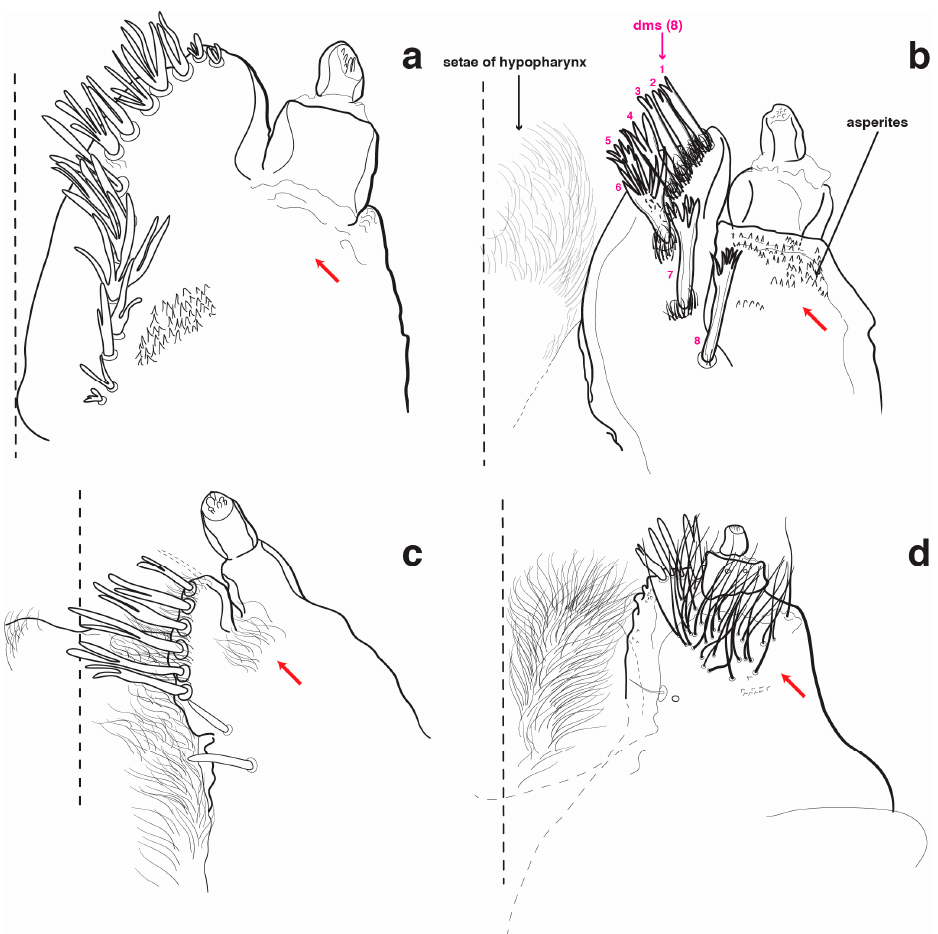
Figure 43. Hypopharynx, mala, and maxillary palp, larva, dorsal view: ( a ) Sipalinus ; ( b ) Poteriophorus ; ( c ) Nephius (=Anius); and ( d ) Cyrtotrachelus. Dms : dorsal malar setae. 4. Arrangement of dorsal malar setae (dms) (Figure 44) a. Regularly aligned in single row ( dms7, 8 may sometimes be more lateral, but always in a single